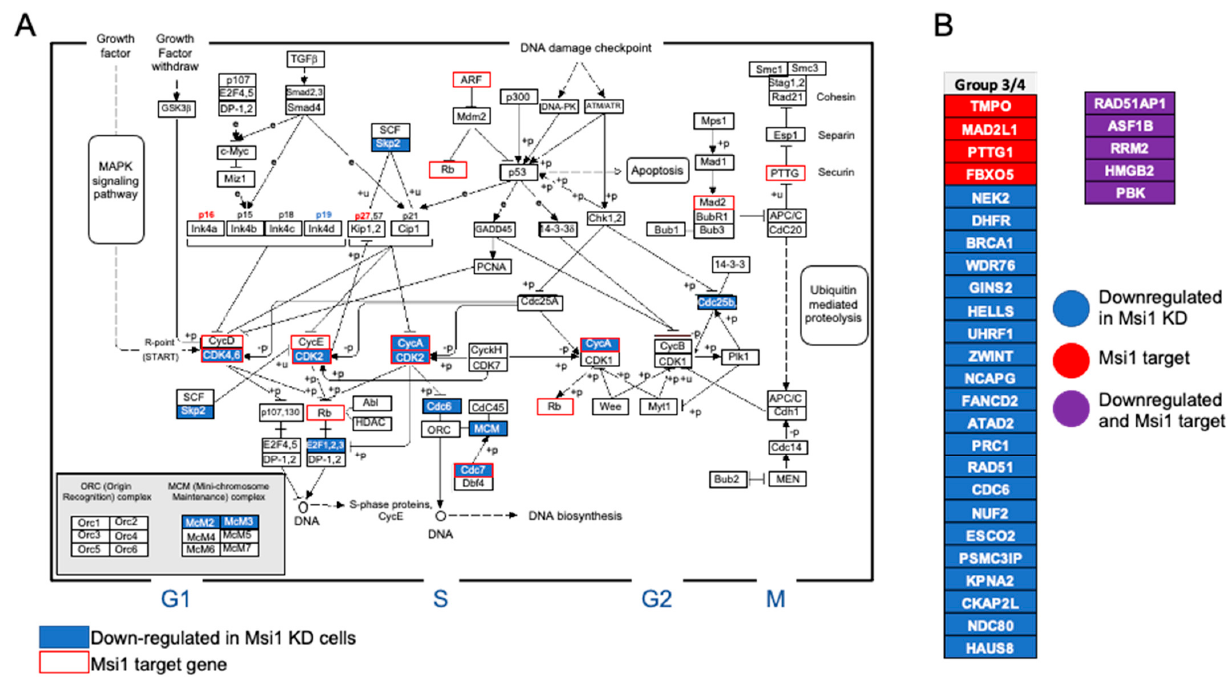
Figure 4. The impact of Msi1 on the cell cycle shown on the KEGG’s cell cycle pathway . ( A ) Diagram of the cell cycle pathway illustrating the impact of Msi1 regulation. Msi1 targets identified by RIP ‐ seq are labeled in red while downregulated genes after Msi1 knockdown, identified by RNA ‐ seq, are labeled in blue. ( B ) Targets of Msi1 and/or genes downregulated in Msi1 knockdown cells featured as biomarkers of a cell population present in subtypes 3/4 ‐α of MB, characterized by the amplification of cell cycle activity [42].